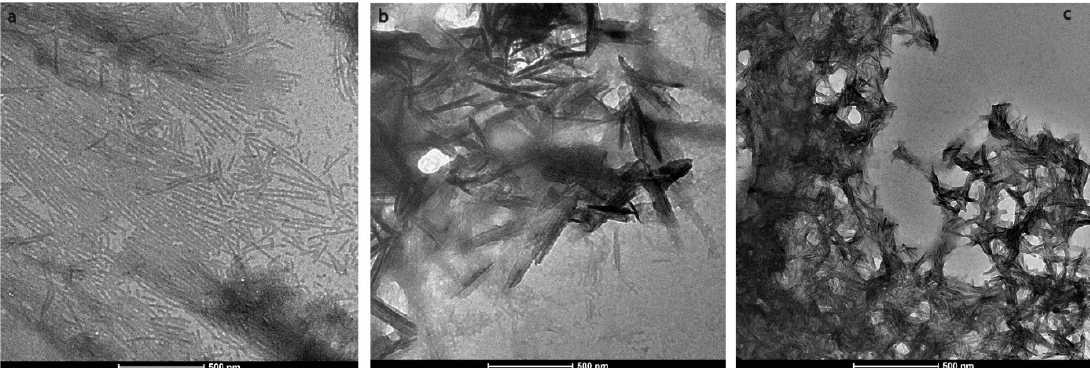
Figure 3. Transmission electron microscopy (TEM) images of H175 self-assembly at pH 6.0 after 14 days’ incubation at 37 °C. ( a ) shows the images of the protein assemblies in rod structures parallelly associated with each other. ( c ) displays another view dominant with the darker needle-like structure. ( b ) shows longer needle-like structures with the gray protein rod structures coexisting.